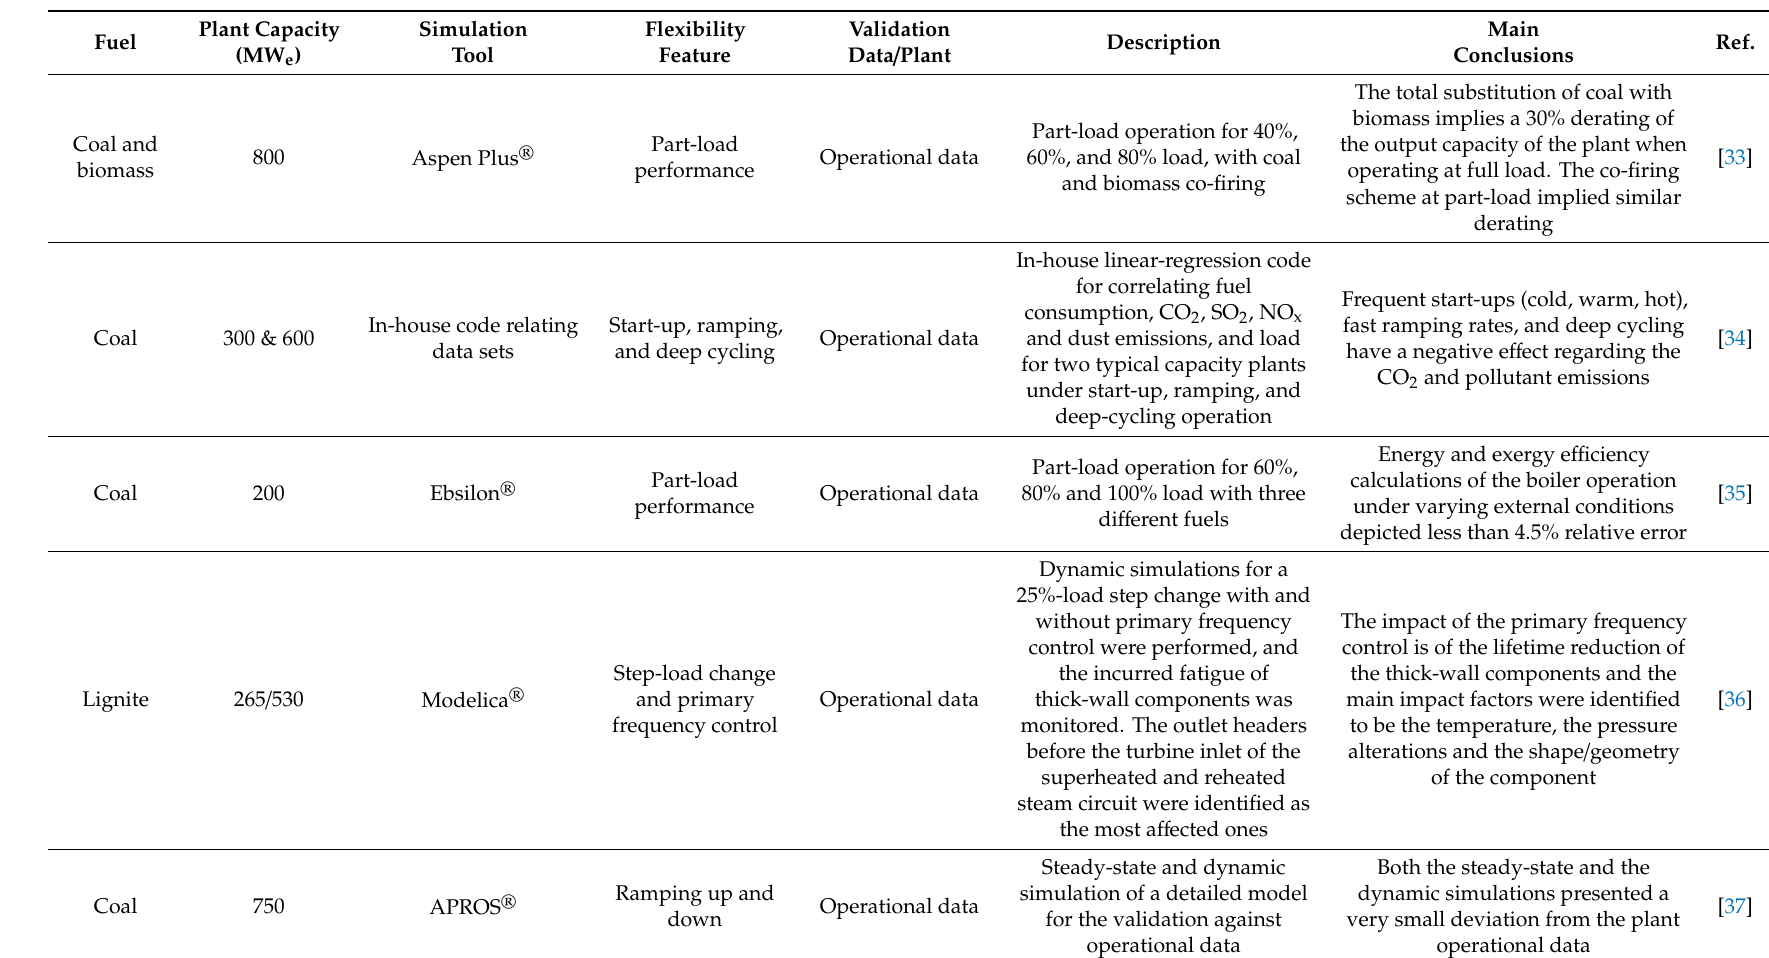
Table 1. Summary of power plants flexible operation